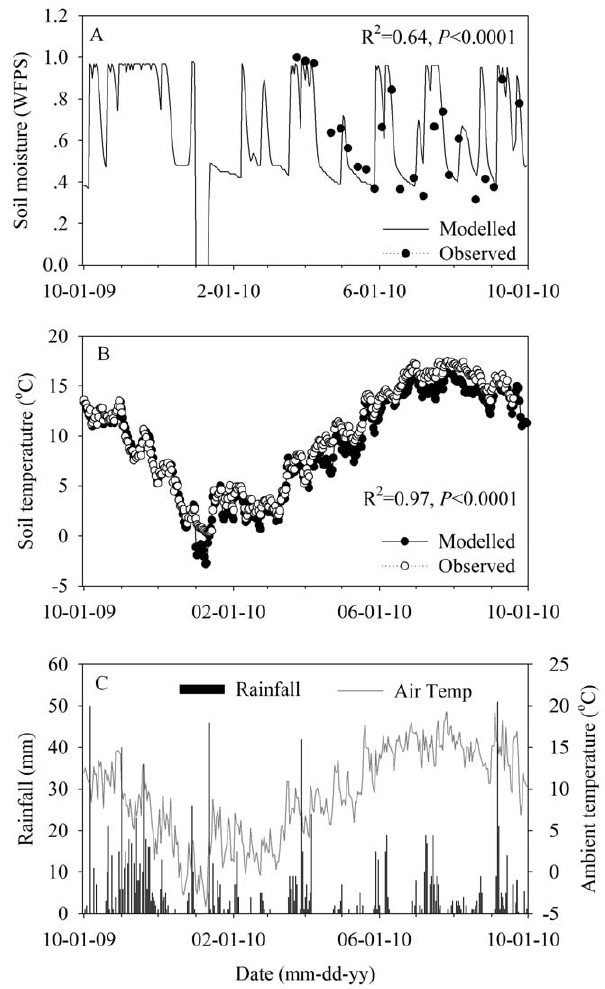
Figure 3. Soil microclimatic and weather conditions. (A) Simulated and measured soil water filled pore space (WFPS) at 5 cm depth, (B) simulated and measured soil temperature at 5 cm depth, and (C) daily rainfall and air temperature. Note: only measured soil moisture and temperature for GG + FN paddocks are presented here as an